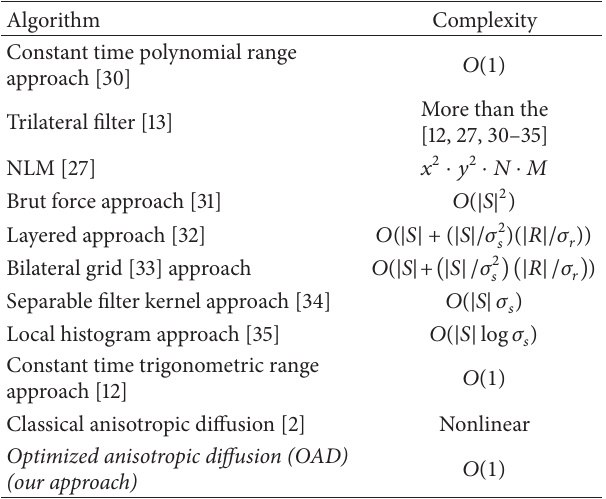
Table 6: Complexity analysis report. The set 𝑆 of all possible image locations. The set 𝑅 of all possible pixel values. 𝜎 is the kernel standard deviation. M × N denotes the image resolution, 𝑥 is patch size, and 𝑦 is the search window